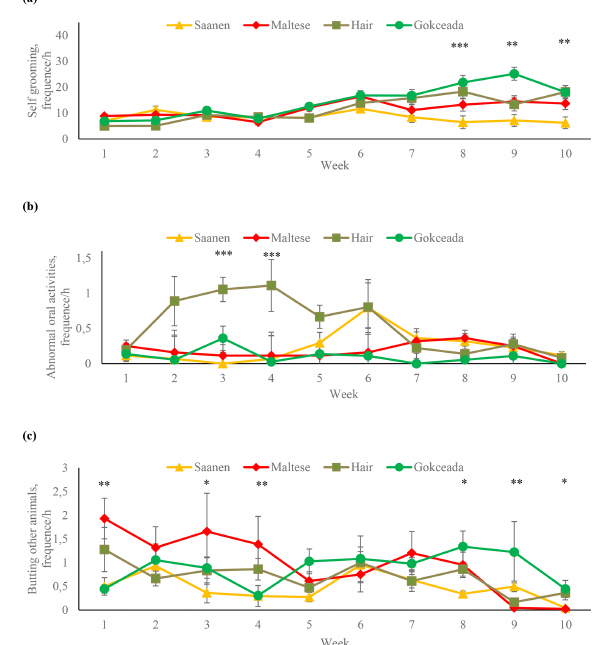
Figure 3. Frequencies of (a) self-grooming, (b) abnormal oral ac- tivities and (c) butting other animals behaviours at different fatten- ing weeks according to breed. ∗∗ P < 0 . 01. ∗∗∗ P < 0 . 001.